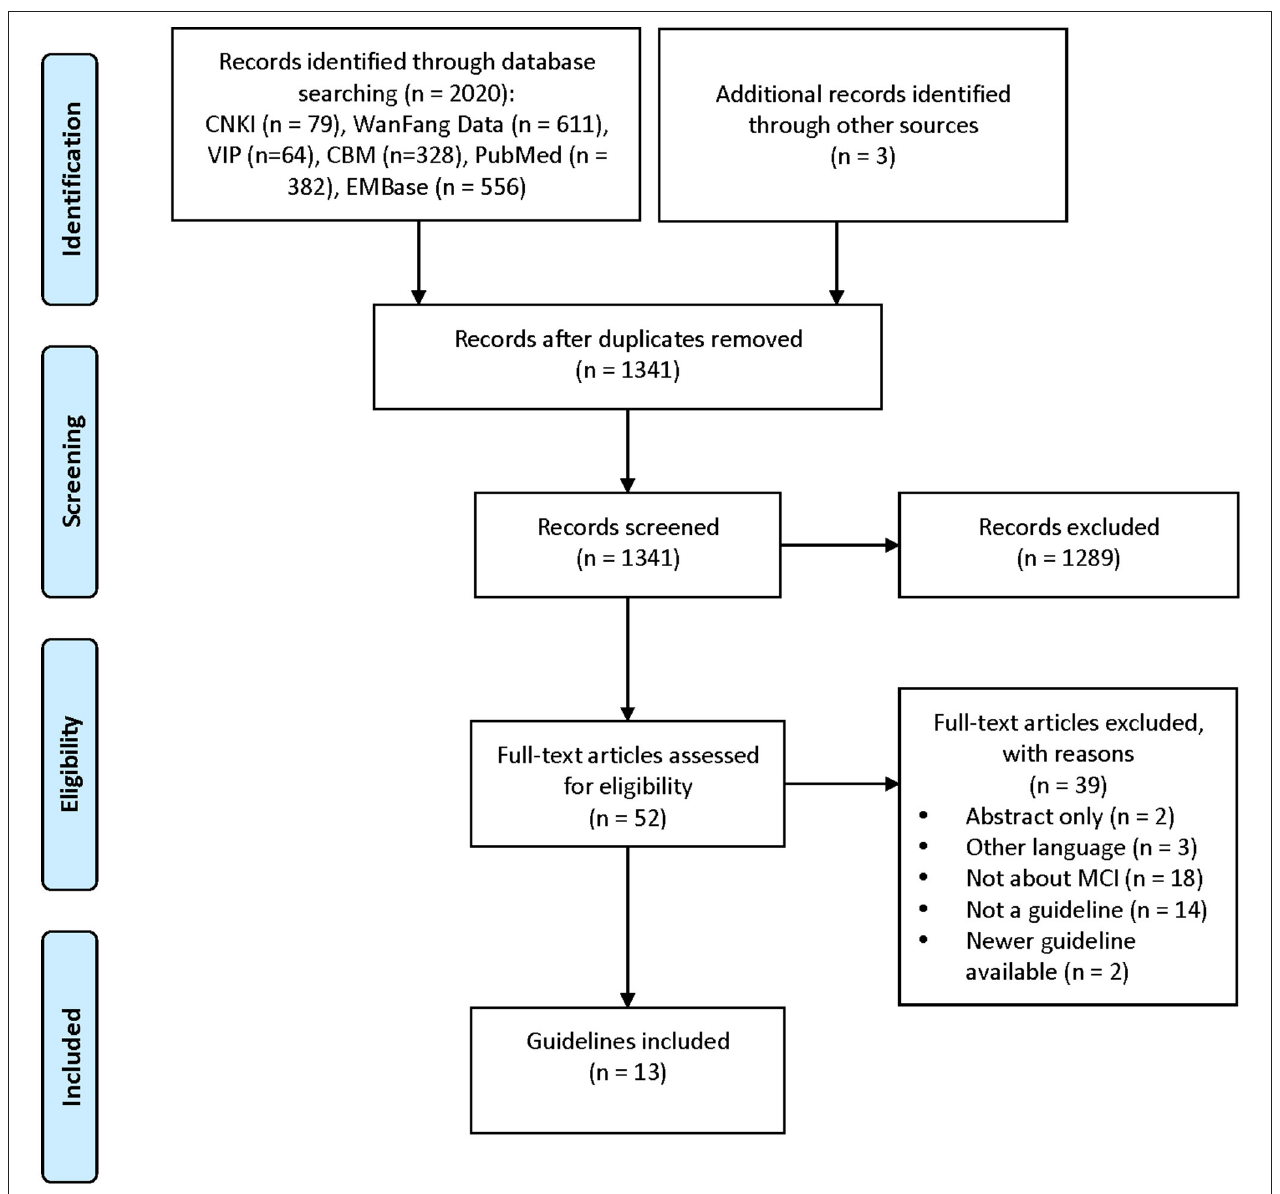
FIGURE 1 | Screening chart of this